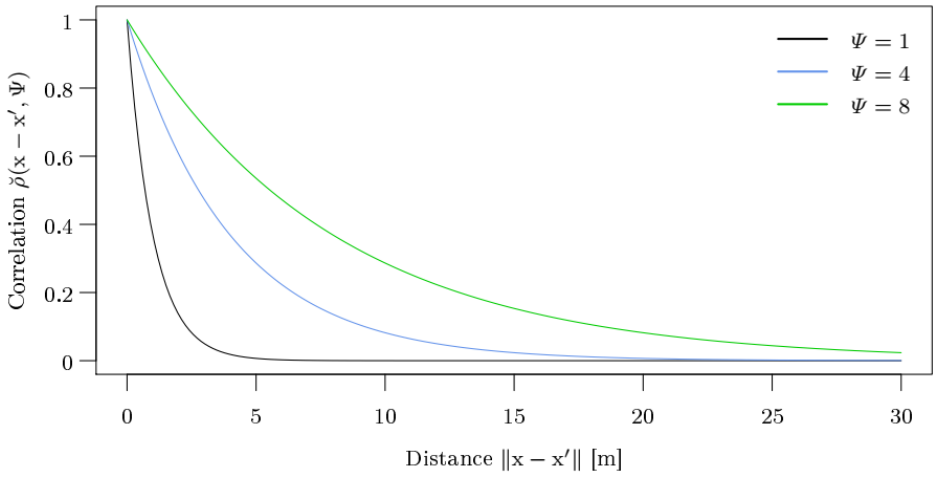
Figure 3. Exponential correlation functions for different scale values Ψ